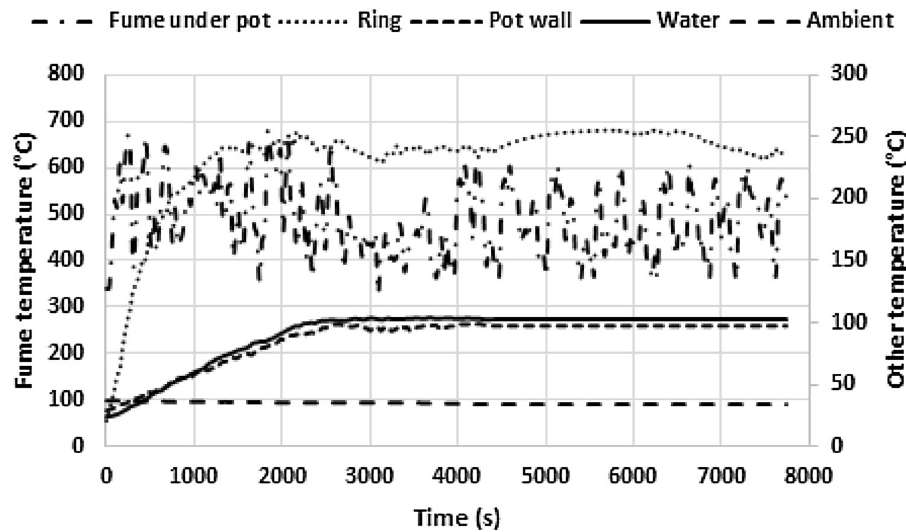
Fig. 5 Fume temperature under the pot (mixed hyphens, principal axis), ring tempera- ture (dotted line, secondary axis), pot wall temperature (small hyphens, secondary axis), water temperature (solid line small hyphen, secondary axis), and ambient tempera- ture (large hyphens, secondary axis), during a water ebullition test, in the configuration with a